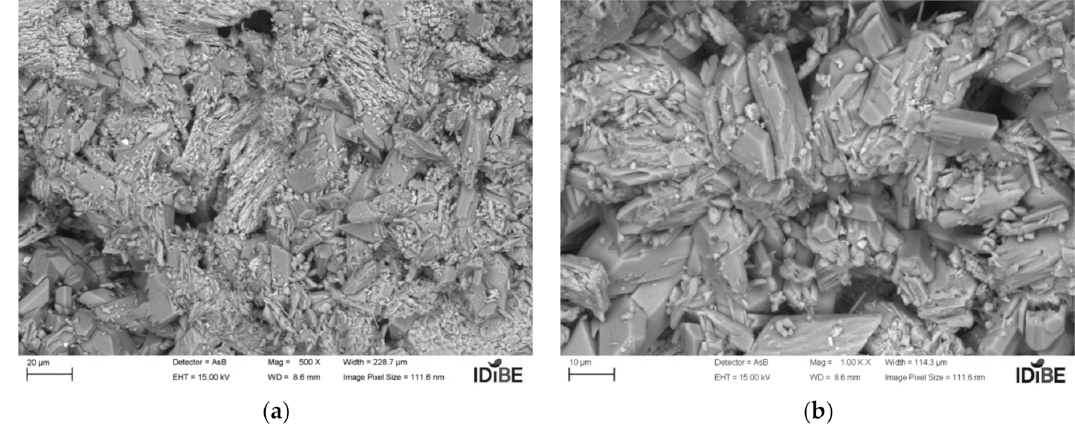
Figure 10. Micrograph of the 0.6% polycarbonate salt compound (lot TAR2): ( a ) 20 µ m; ( b ) 10 µ m (source: the author).